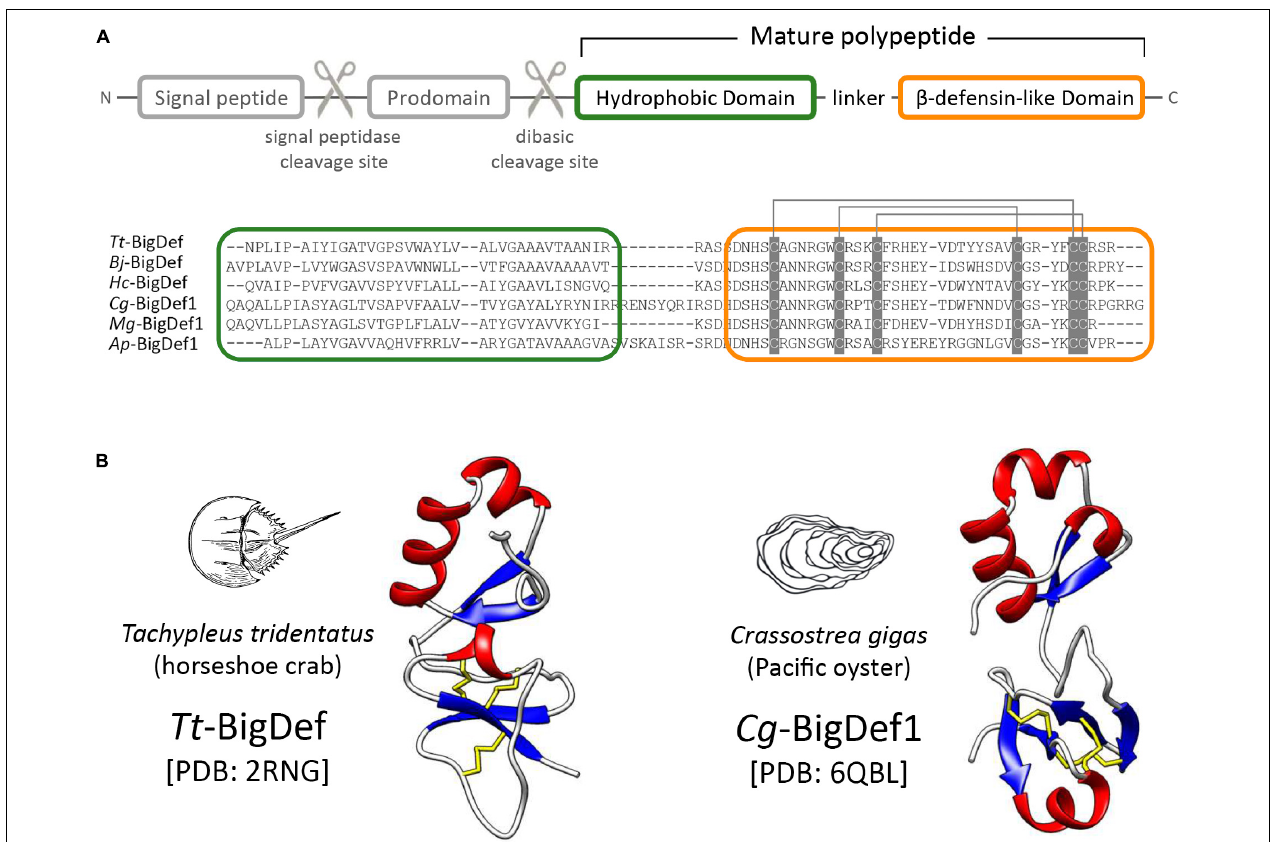
FIGURE 2 | Structural domain organization of big defensins. (A) Big defensin precursors are composed of a signal peptide followed by a prodomain holding a dibasic cleavage site, and a multi-domain polypeptide (mature big defensin). Hydrophobic (green frame) and β -defensin like (orange frame) domains are indicated at the amino acid sequence alignment of certain mature big defensins. Cysteine pairing is indicated by gray lines. GenBank numbers are provided in Supplementary Table S1 . (B) The 3D structure of canonical big defensins shows the two structural domains connected by a flexible